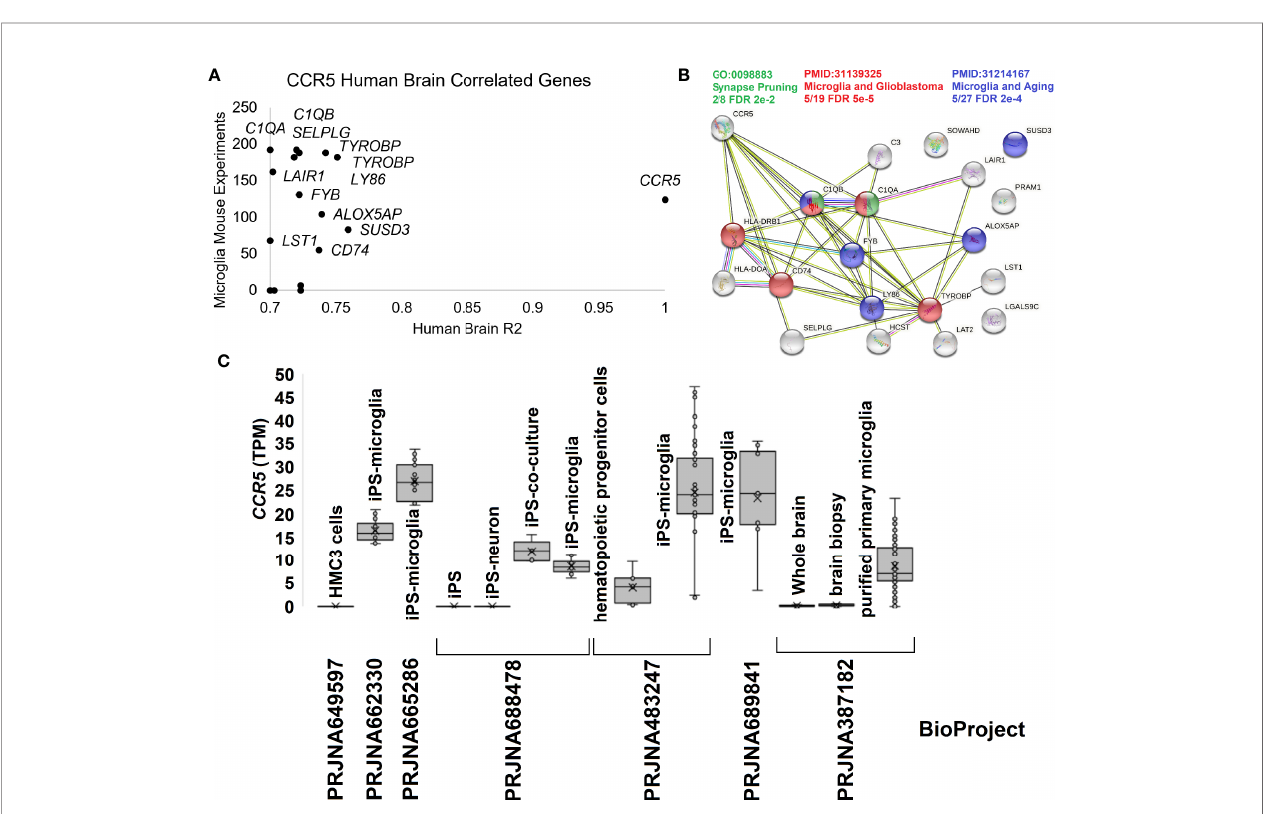
FIGURE 5 | Human brain CCR5 and microglia. (A) The correlation of genes to CCR5 from the Allen Brain Atlas Human Brain microarray data for 500 samples relative to their expression in mouse microglia single-cell experiments. The x-axis shows the genes R 2 from microarray relative to CCR5 expression, while the y-axis shows the number of experiments the gene is detected in mouse single-cell datasets for microglia. (B) STRING protein network for genes in panel (A) showing the enrichment of synapse pruning (green), microglia/glioblastoma (red), and microglia/aging (blue) genes. (C) Expression of CCR5 in transcripts per million (TPM) from seven BioProjects of human microglia cells or related